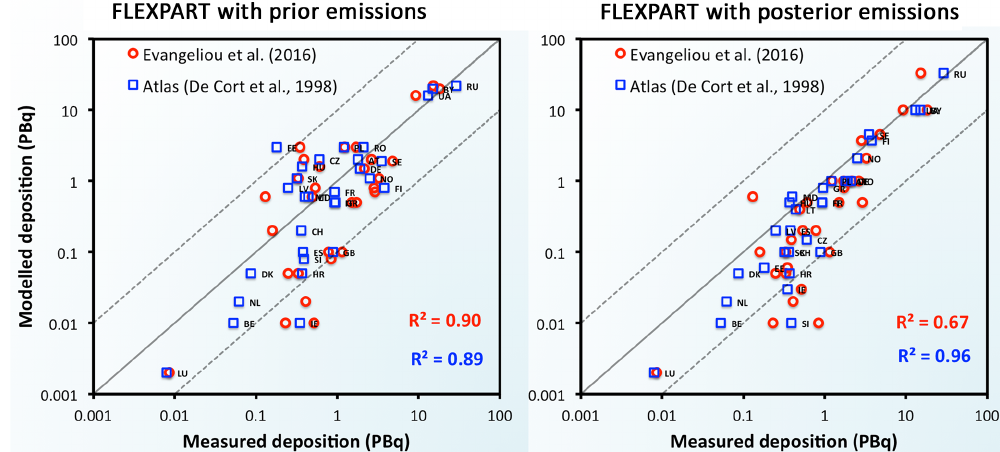
Figure 9. Country-by-country total cumulative deposition of 137 Cs simulated with FLEXPART model using the prior and posterior emissions vs. the estimated ones from the Atlas; De Cort et al., 1998) and from Evangeliou et al. (2016). The different countries are highlighted using their official country codes (Austria, AT; Belarus, BY; Belgium, BE; Croatia, HR; Czech Republic, CZ; Denmark, DK; Estonia, EE; Finland, FI; France, FR; Germany, DE; Greece, GR; Hungary, HU; Ireland, IE; Italy, IT; Latvia, LV; Lithuania, LT; Luxembourg, LU; Moldavia, MD; the Netherlands, NL; Norway, NO; Poland, PL; Rumania, RU; Russia, RU, European part; Slovak Republic, SK; Slovenia, SL; Spain, ES; Sweden, SE; Switzerland, CH; Ukraine, UA; and United Kingdom,